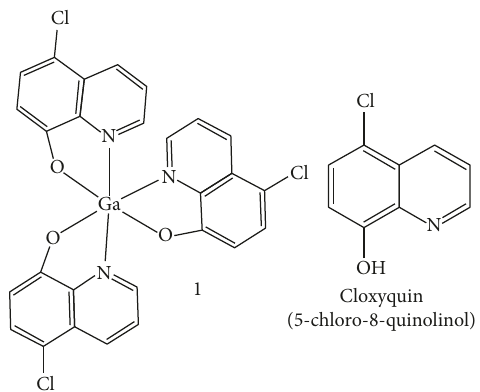
Figure 1: Schematic representation of compounds investigated in this